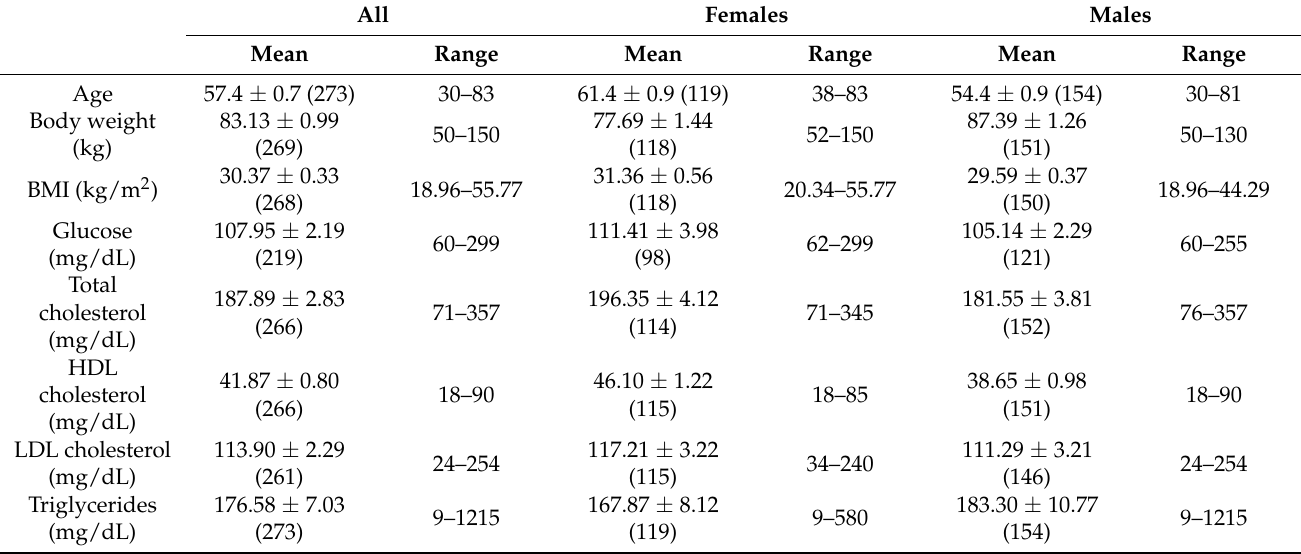
Table 1. Clinical and biochemical features of individuals in the study group used for metabolomic profiling. Individuals were selected for absence of coronary stenosis. Data are given as means ± SEM. Number of cases are reported in parentheses. Gender differences were tested using two-way ANOVA.